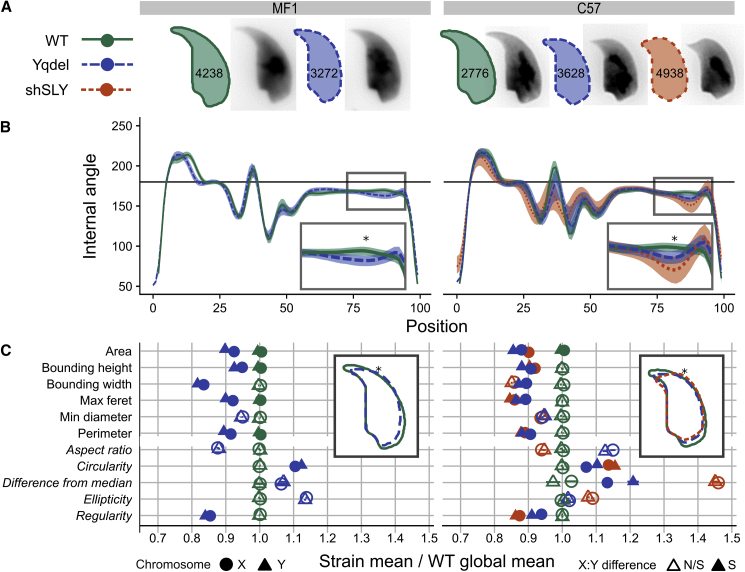
Morphological Differences between Strains(A) Consensus nuclear outlines for each strain alongside an example DAPI-stained nucleus. Numbers indicate the number of nuclei analyzed for each strain.(B) Angle profiles from each strain [25]. The x axis is an index representing percentage of the total perimeter as measured counterclockwise from the apex of the sperm hook. The y axis represents the interior angle measured across a sliding window centered on each index location—a smaller angle represents sharper curvature at any given point; thus (e.g.), the hook apex at index 0 shows the smallest angle. The insets highlight the increased acrosomal curvature seen in the mutant genotypes, with “∗” indicating the point of greatest difference in curvature between genotypes at index 85.(C) Comparison of X- and Y-bearing sperm in standard morphometric parameters (see [25] for definitions), compared to mean wild-type values. Italics indicate size-independent parameters. See Table S3 for more details. Inset: overlapping consensus nuclear outlines for each genotype are shown, with the location of index 85 marked ∗.See also Figures S2 and S3.